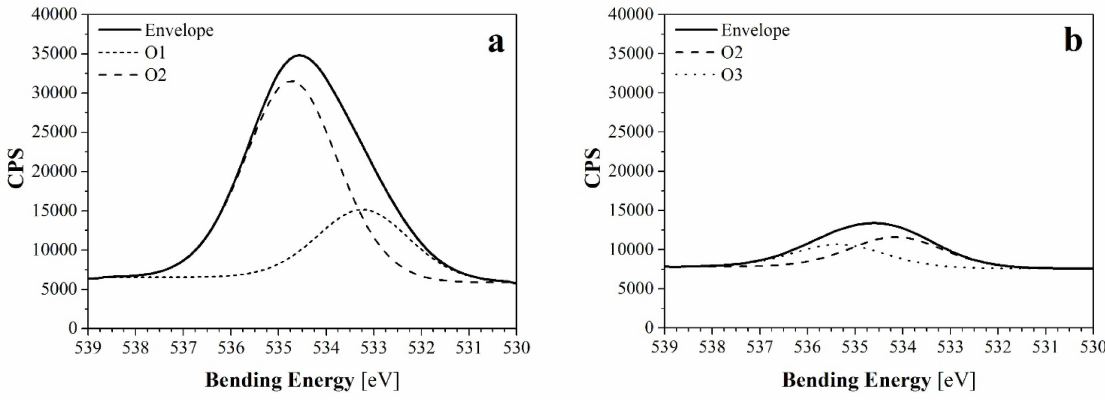
Figure 9. Deconvoluted curves of XPS O1s peaks of ( a ) NW C-Ar5; and ( b ) NW C-Ar5-Et10